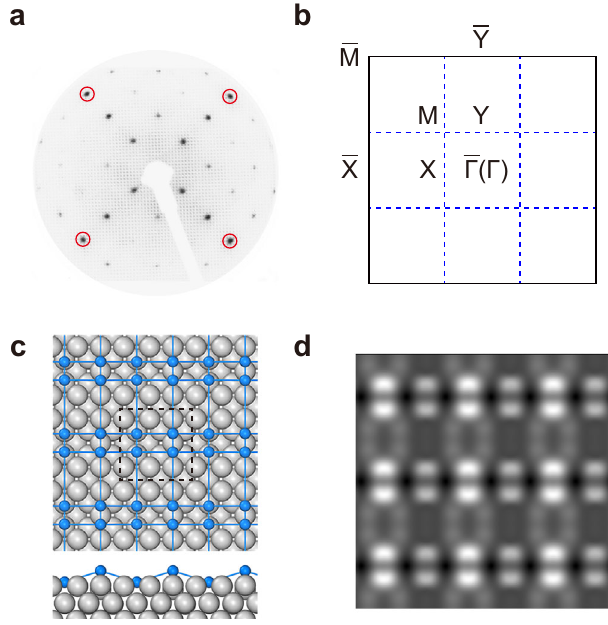
Fig.2|StructureoftheSi/Ag(001)system.a LEEDpatternofSigrownonAg(001). Red circles indicate the diffraction patterns from the 1×1 lattice of Ag(001). Si forms a 3×3 superstructure with respect to the substrate. b Schematic drawing of the BZs of Si and Ag(001). c Relaxed structure model of Si/Ag(001). Blue and gray balls indicate the Si and Ag atoms, respectively. d Simulated STM image of Si/ Ag(001) at bias voltage of −